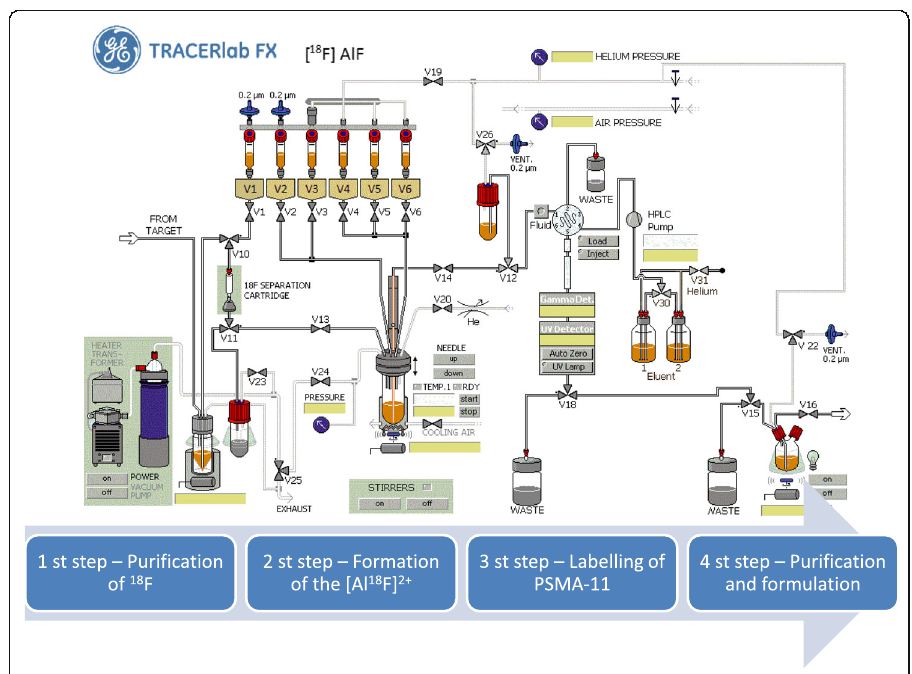
Fig. 2 Upper: schematic representation of the [ 18 F]AlF-PSMA-11 radiochemistry, lower: diagram of synthesis steps of [ 18 F]AlF-PSMA-11